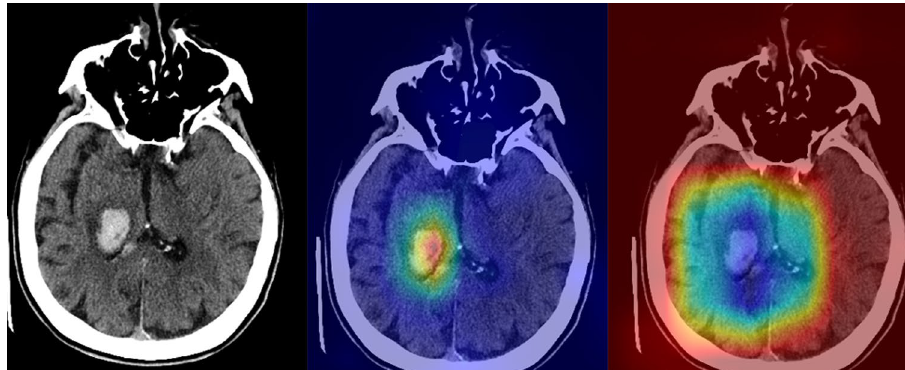
Figure 3. A 68-year-old female with known hypertension (The images were created by the authors using open- source software, Matplotlib v3.5, Python v3). A right thalamic hematoma extended into the adjacent ventricular system on a non-contrast head CT scan (right). NormGrad (middle) method generates more delicate saliency maps than Grad-CAM (left), highlighting the thalamic hematoma and its ventricular extension. The average quality scores were 3.6 points and 2 points for the NormGrad and Grad-CAM, respectively. Please note that the observers evaluated saliency maps with the same color spectrum, and the current color maps are adjusted for representative purposes.